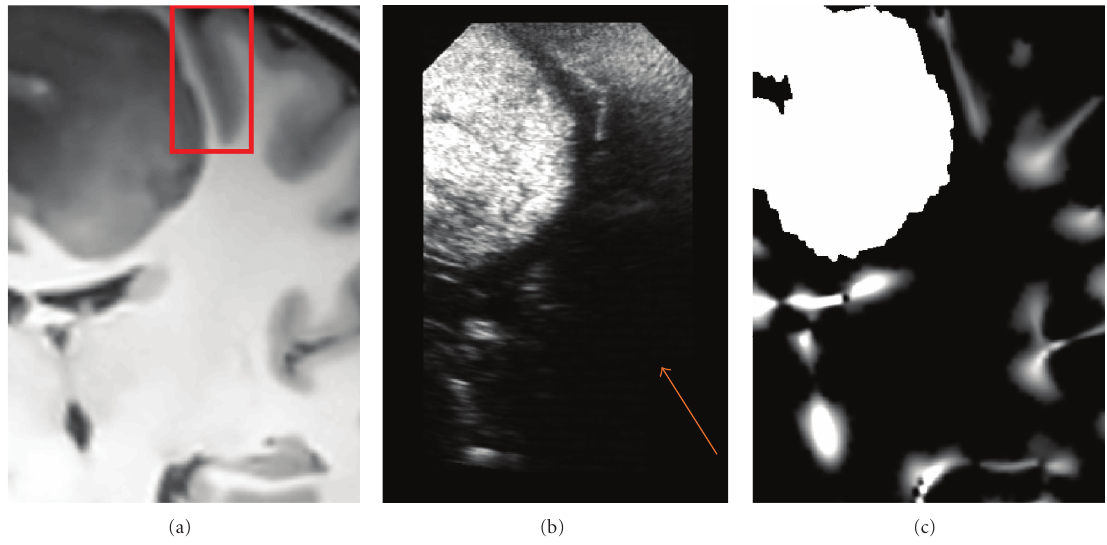
Figure 4: Patient 3. (a) The denoised MR image corresponding to US image (b). (c) The probability map based on MLvv operator and extracted from denoising MR image. The initial error is estimated around 5mm by the experts for this patient. In the red box, the MLvv operator e ffi ciently detects the sulci also visible in the US image. This case presents a limited field of view while the lesion is large. Moreover, an acoustic shadow is visible on the right lower part of the US image (indicated on the US image by a narrow).